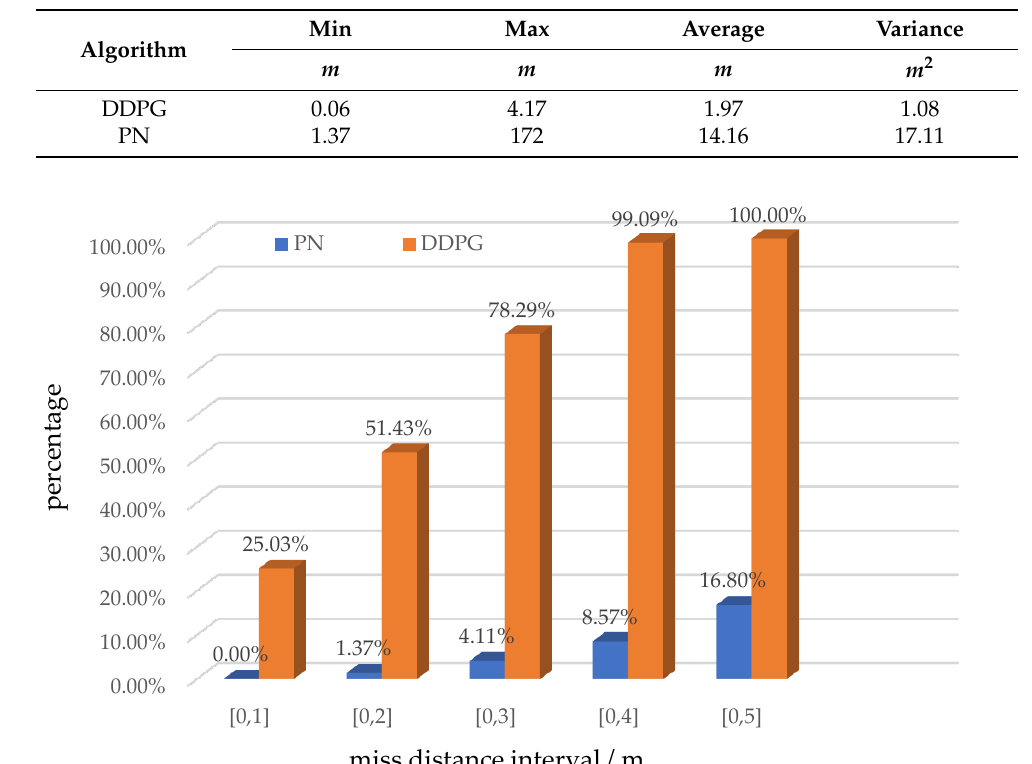
Table 5. Miss-distance statistics.